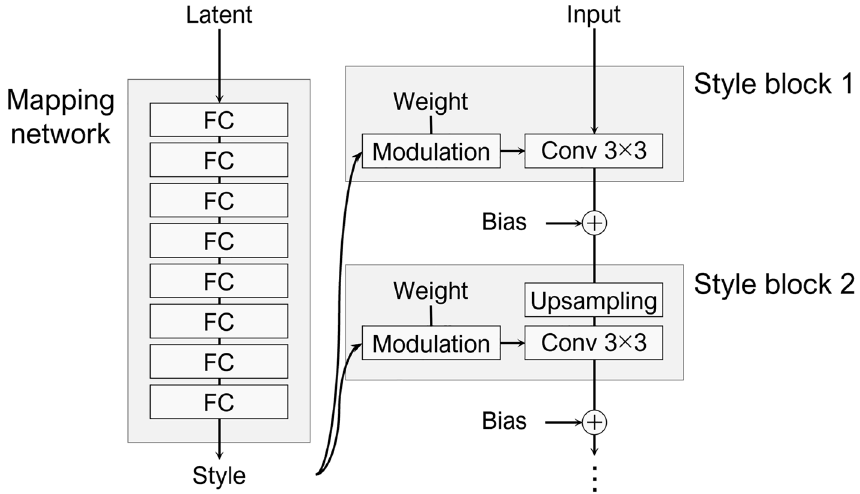
Figure 3. Basic structure of StyleGAN.